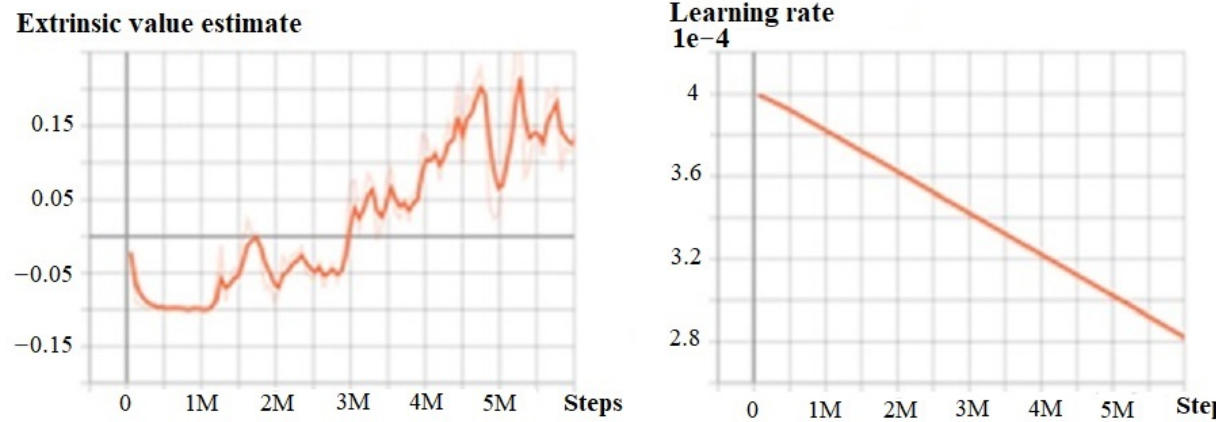
Figure 3. Evolution of learning parameters during training (Scenario 4).